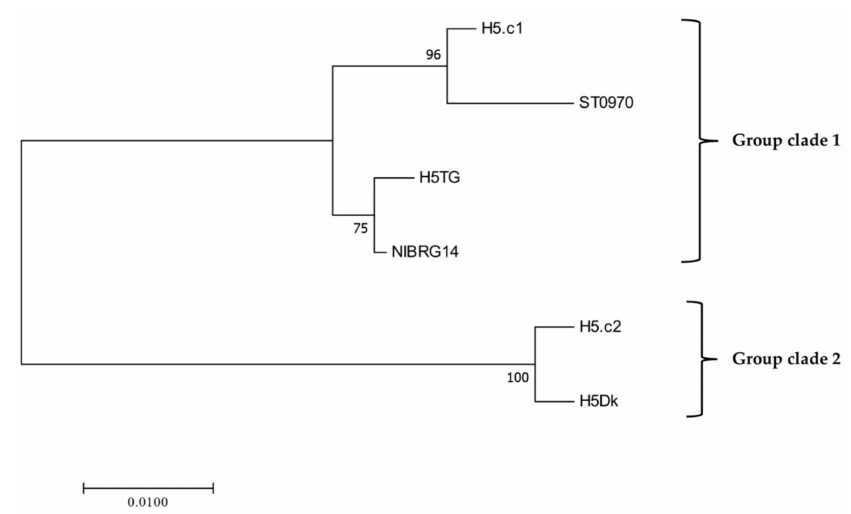
Figure A2. Evolutionary relationships of HA proteins